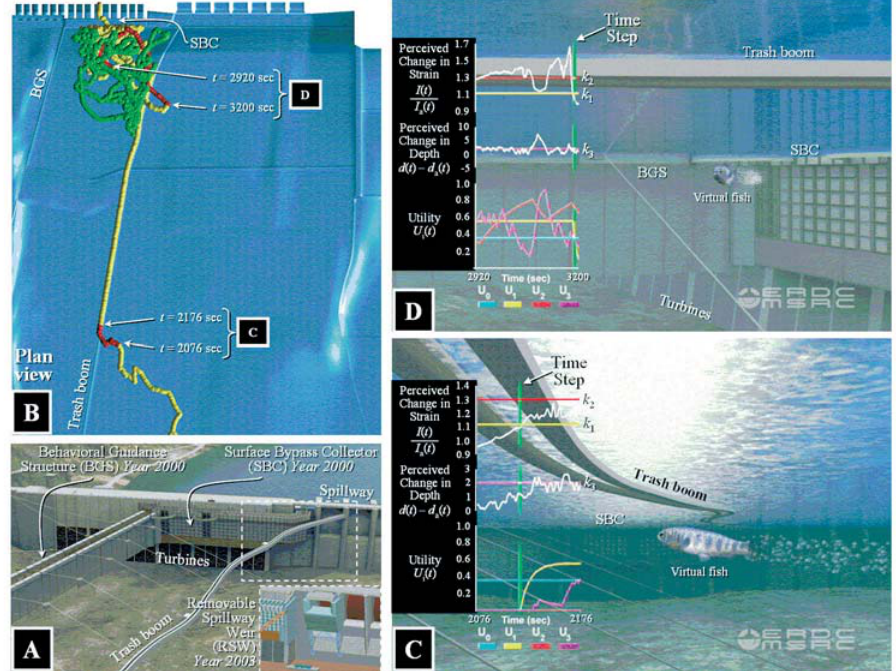
Fig. 3. Project features at Lower Granite Dam on the Snake River, WA USA for 2000 and 2003 studies [A]. The Behavioral Guidance Structure (BGS) is intended to guide emigrants to the Surface Bypass Collector (SBC) and occlude them from the 3 turbine intakes nearest the shore. In 2003, a Removable Spillway Weir (RSW) was deployed in the spillbay nearest the powerhouse in lieu of the SBC; the BGS was also removed. Acoustic-tag emigrant track (green in [B]) provided by U.S. Geological Survey (Cash et al. , 2002). CFD model depiction of forebay hydrodynamic pattern for [B], [C] and [D] in Fig.